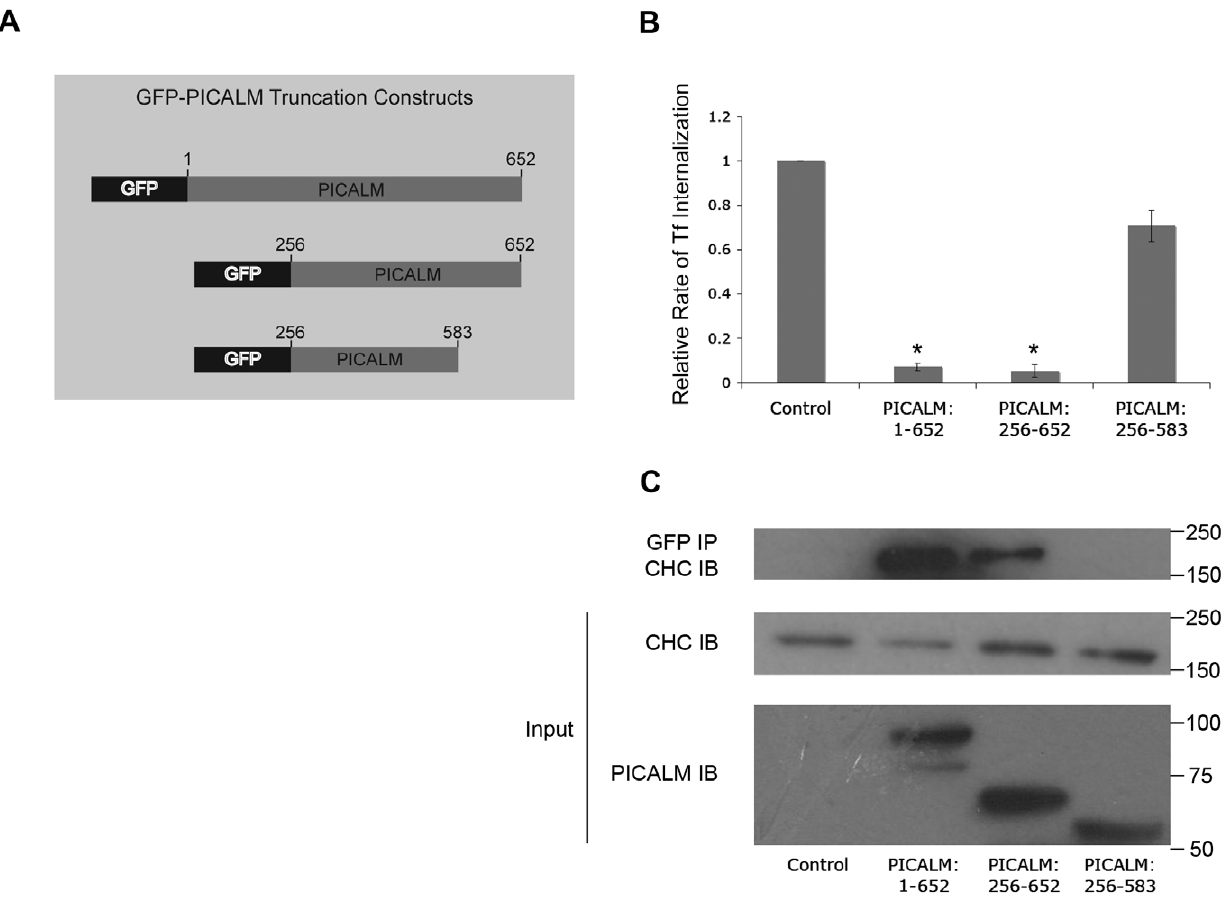
Figure 1. The carboxy-terminal 69 amino acids of PICALM are essential for binding clathrin and interfering with TfR endocytosis. ( A ) Schematic representation of amino-terminal-tagged GFP-PICALM fusion proteins. ( B ) TfR internalization in HEK293 cells transiently transfected with empty vector (control), full length PICALM (PICALM: 1–652), amino-terminal truncated PICALM (PICALM: 256–652), or a PICALM mutant missing both the amino and carboxy-terminal regions (PICALM: 256–583). The relative rate of endocytosis was calculated as described in Materials and Methods. N exp =11. *p , 0.001 compared with control. ( C ) Western blot of proteins co-immunoprecipitated (IP) with anti-GFP antibody and immunoblotted (IB) with anti-clathrin heavy chain (CHC) antibody (upper panel). Cell lysates (input) were also immunoblotted with anti-CHC and anti-PICALM antibodies (lower panels). The molecular weights of GFP-PICALM, GFP-PICALM:256–652 and GFP-PICALM:256–583 are 97kD, 70kD and 62 kD, respectively.